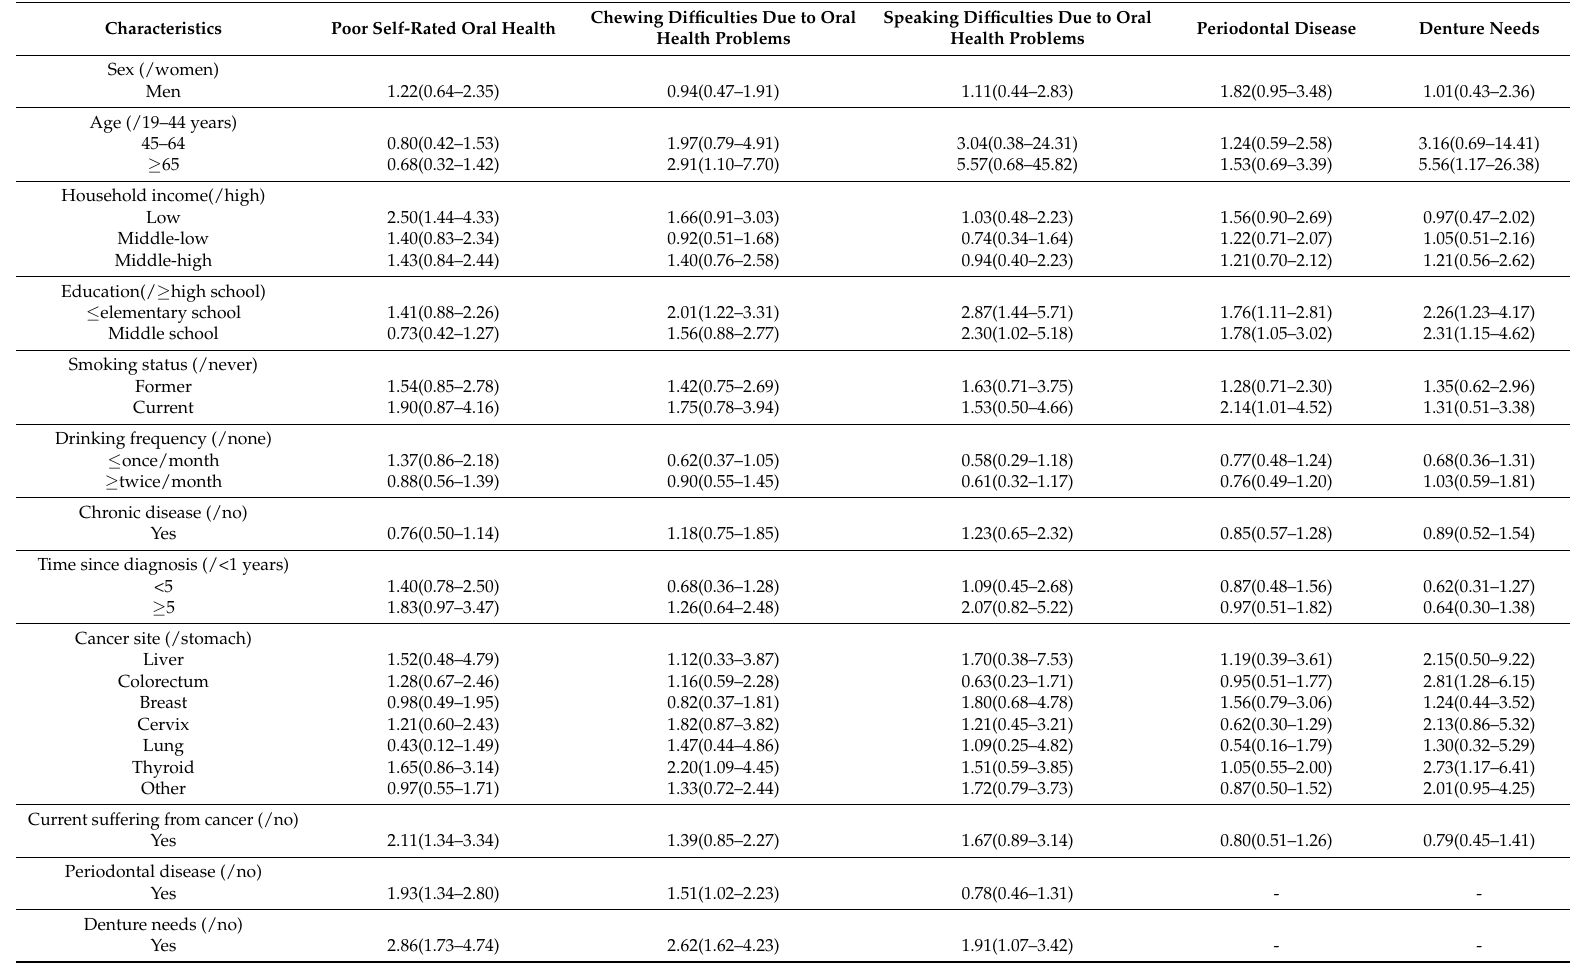
Table 3. Associated factors with oral health status among cancer